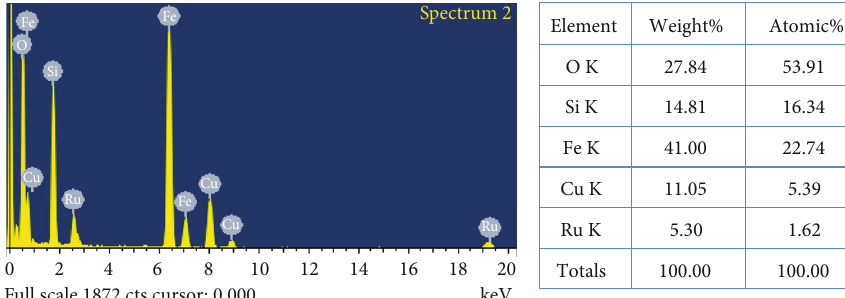
Figure 4: TEM-EDX spectrum of Fe